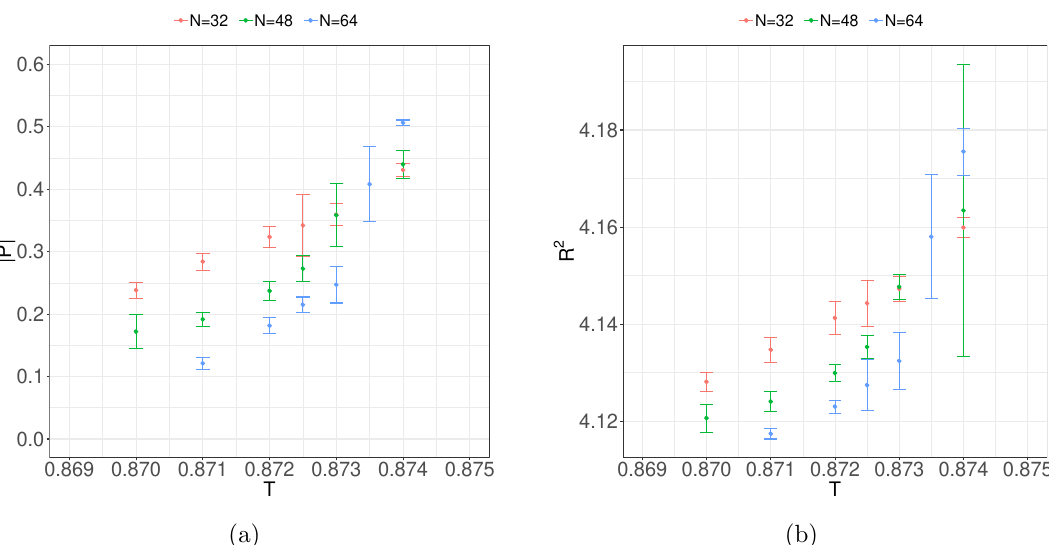
Figure 8. a) j P j vs T and b) R 2 vs T , both for L = 24, D = 26 and various N . A naive large- N extrapolation of j P j is consistent with zero within errors for T (cid:20) 0 : 873 (using data for N = 48 and N = 64 only near the transition).